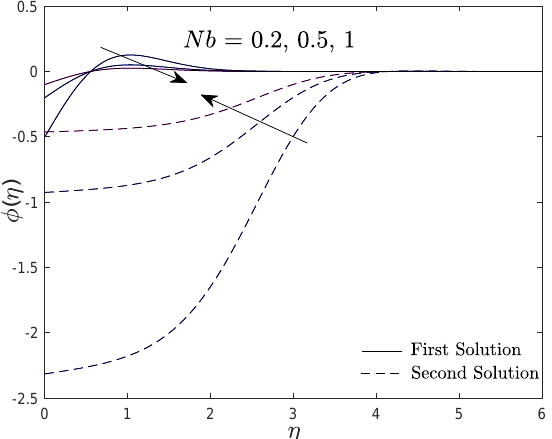
Figure 8. Nanoparticles’ volume fraction profile in limiting range of Nb when Le = Pr = 1, Nt = 0.2, γ 1 = 5, γ 2 = 10, M = 0.5 and λ = −